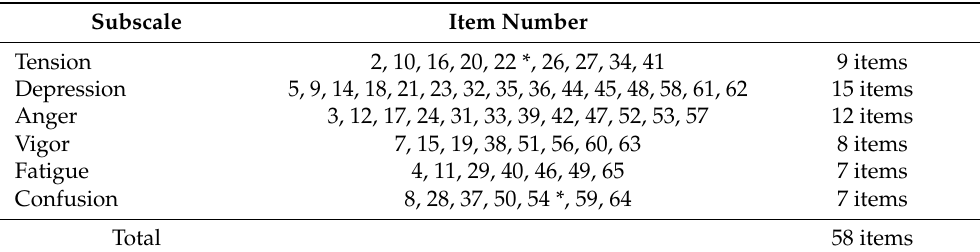
Table 2. Profile of Mood State